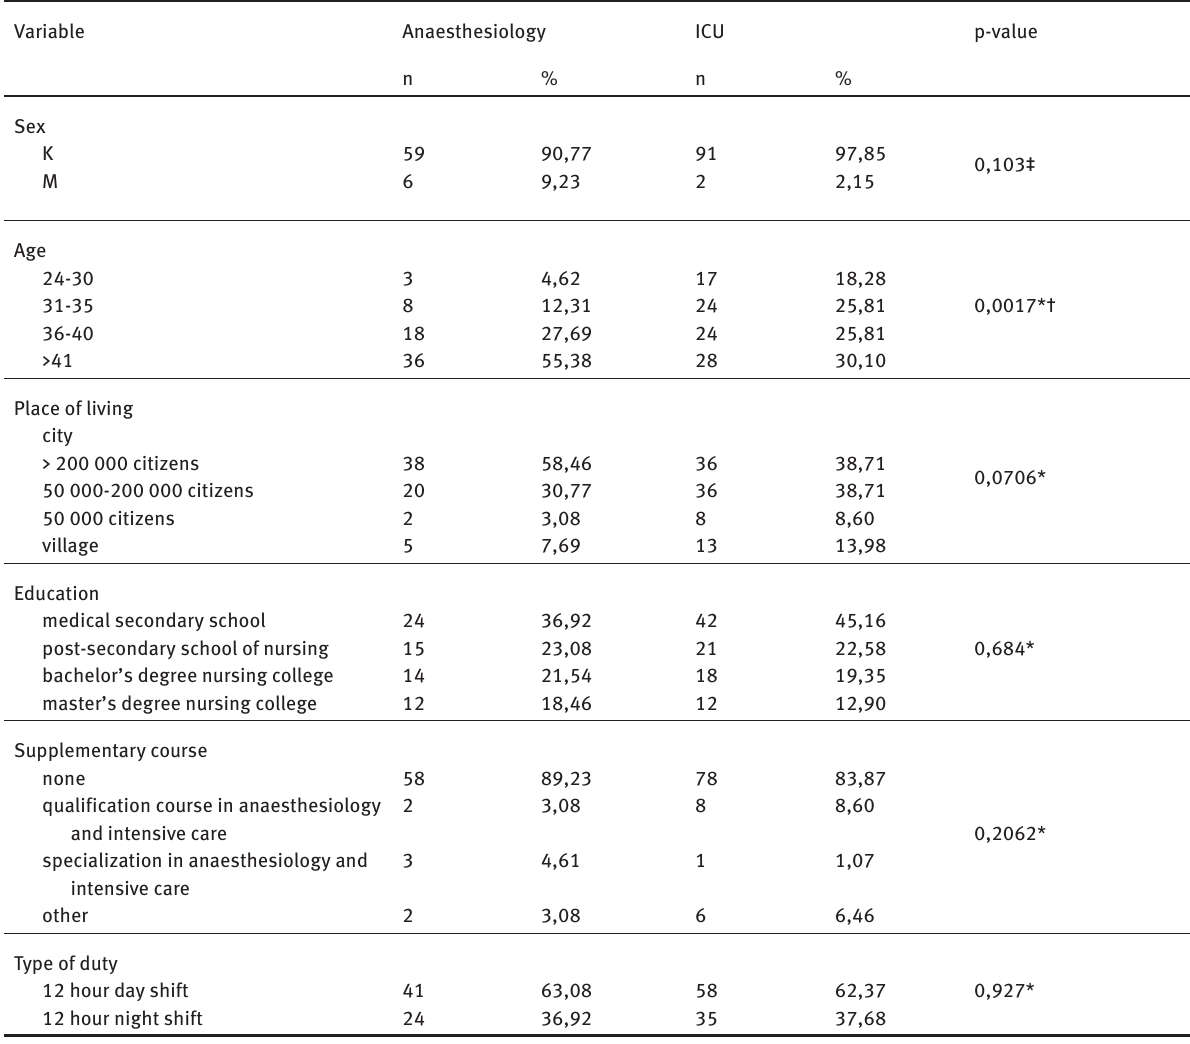
Table 1: Socio-demographic characteristics of the nursing staff in anaesthesiology and intensive care units – sex, place of living, education, type of duty